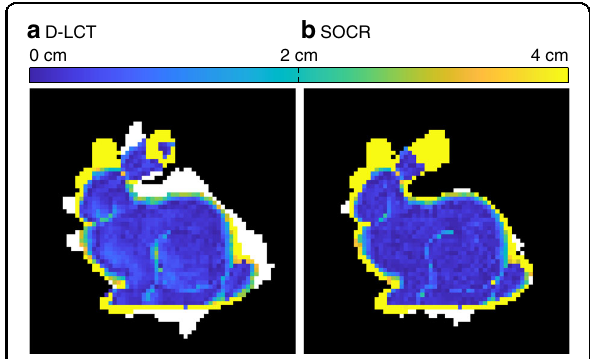
Fig. 5 Absolute depth error of the D-LCT and the SOCR reconstruction. The absolute depth error of the D-LCT reconstruction is shown in a . The absolute depth error of the SOCR reconstruction is shown in b . The SOCR reconstruction has a smaller absolute depth error at the chest and legs of the bunny. The D-LCT reconstruction has 254 excessive voxels outside the ground truth, which is 20.63% of the non-zero voxels contained in the ground truth (1231), while the proposed algorithm has 46 excessive voxels (3.74%), which is